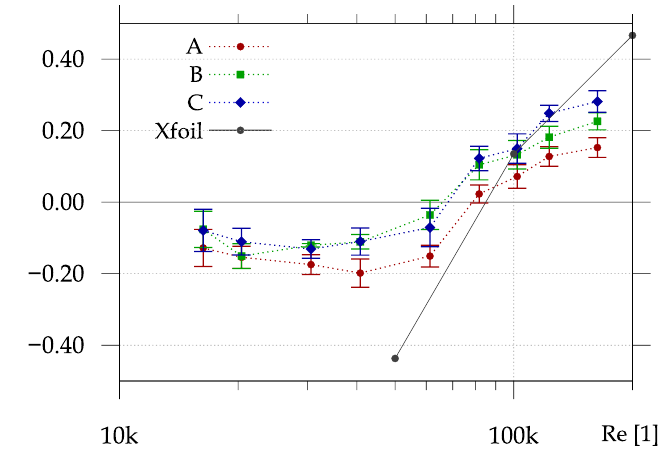
Figure 9. Balance measurement of the lift coefficient. The theoretical results for ideal geometry are displayed as well. Angle of attack α = 0 ◦